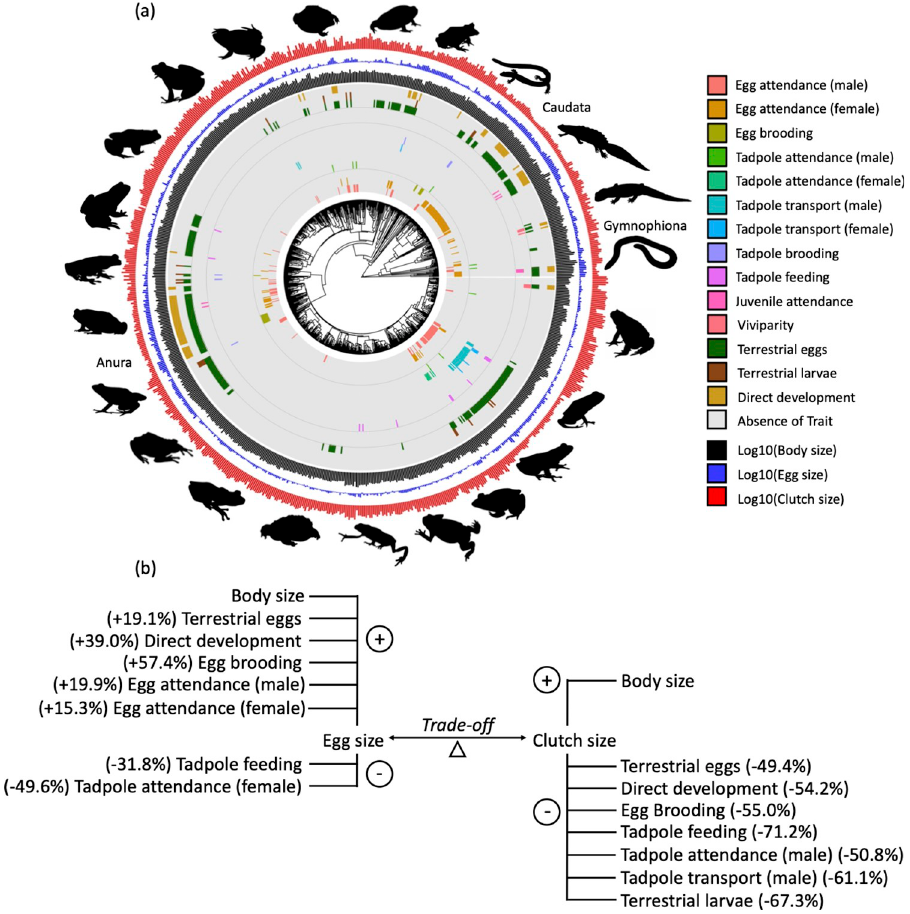
Fig 3. Summary of results on the evolution of egg size–clutch size trade-off. (A) Distribution of parental care forms, offspring habitat, direct development, and life history traits in amphibians ( n = 805 species; raw data in S1 and S2 Data). All variables, except clutch size, egg size, and body size, are binary. (B) Summary of the significant associations for the trade-off between egg size and clutch size, combining their respective reduced models (S3B and S3D Table). Variables associated with increases in egg or clutch size are above the trade-off and indicated with a plus; variables associated with decreases in egg or clutch size are below the trade-off and indicated by a minus. For each variable, we report in brackets the percentage of change in egg or clutch size computed for an average-sized amphibian with average clutch size or egg size, respectively (S4A Table for egg size and S4B Table for clutch size).